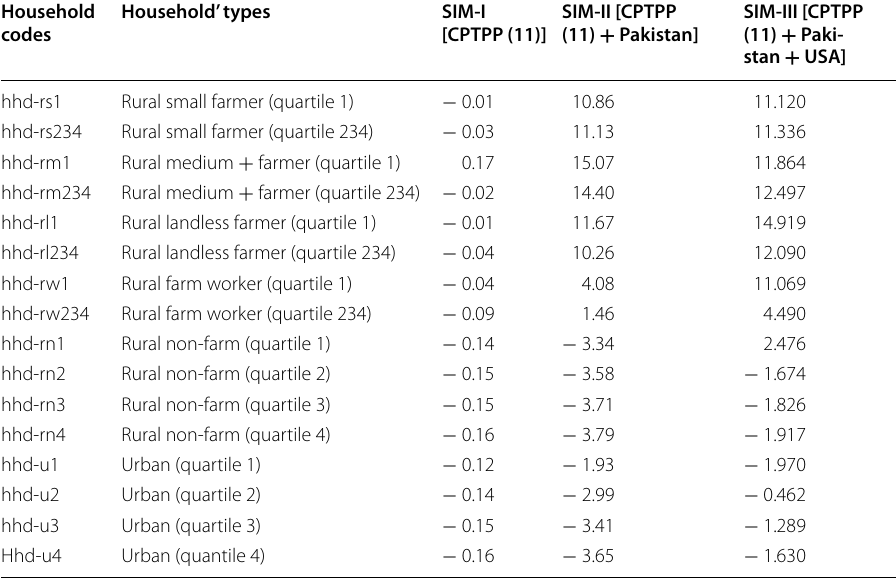
Table 7 Impact of CPTPP on household income Source : Author’s simulation Household